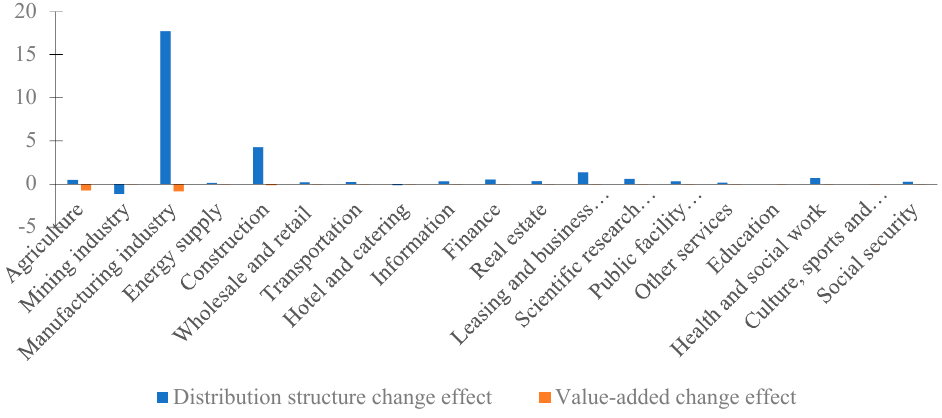
Figure 5. Distribution structure change effect and value-added change effect of various sectors in China (unit: CNY 100 million).